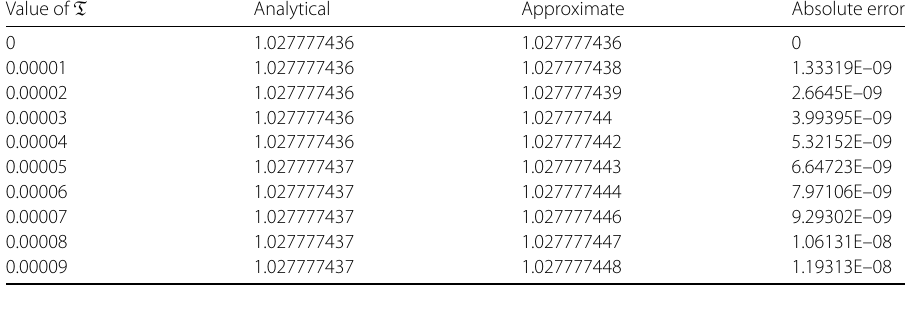
Table 5 Numerical values of the solutions through the ExCBS method Value of T Analytical Approximate